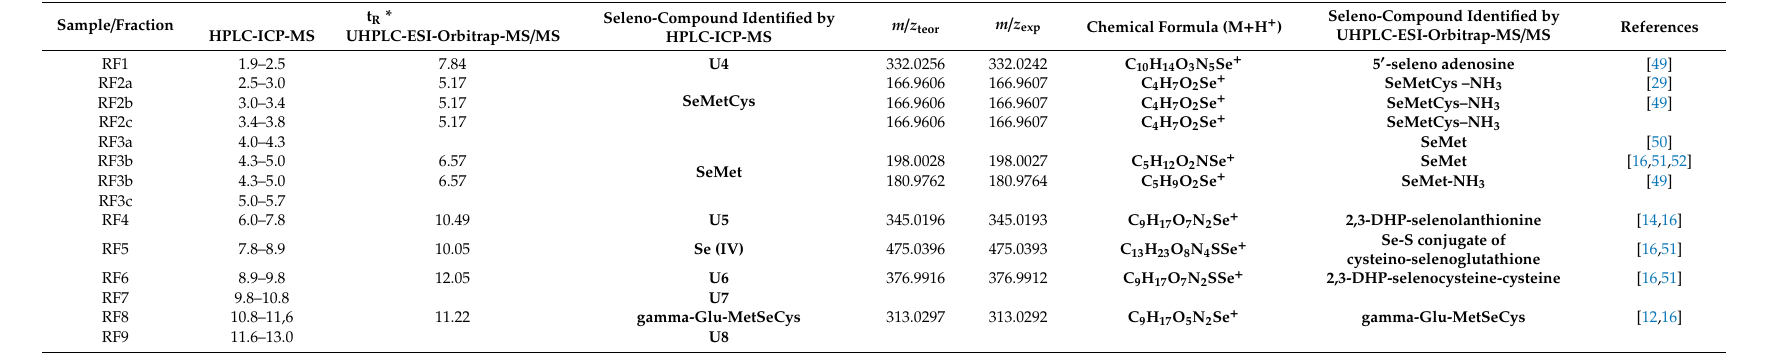
Table 3. Selenium compounds identified in the extract of radish sprouts enriched in selenium. Sample /